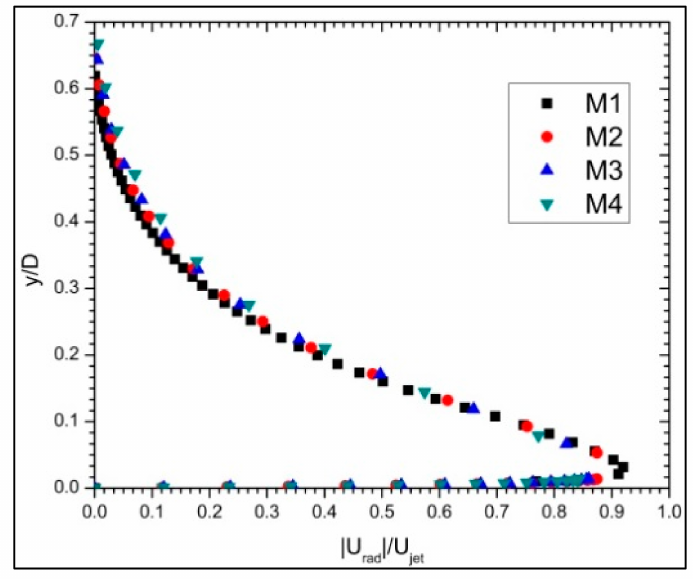
Figure 2. Normalised radial velocity |Urad|/Ujet at r/D = 1 (grid